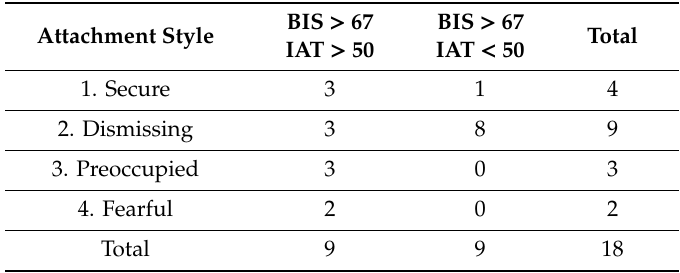
Table 1. Contingency matrix for people in the sample trespassing the impulsivity threshold. BIS > 67 Attachment Style